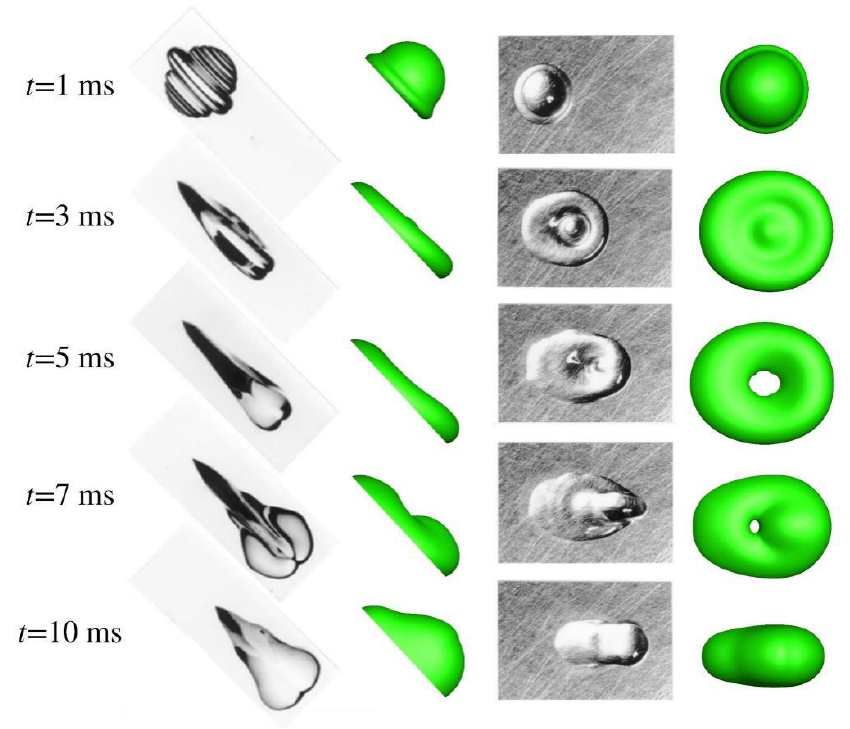
Figure 8. Oblique impact (45°) of water droplet. The left is the side view, and the right is the top view.